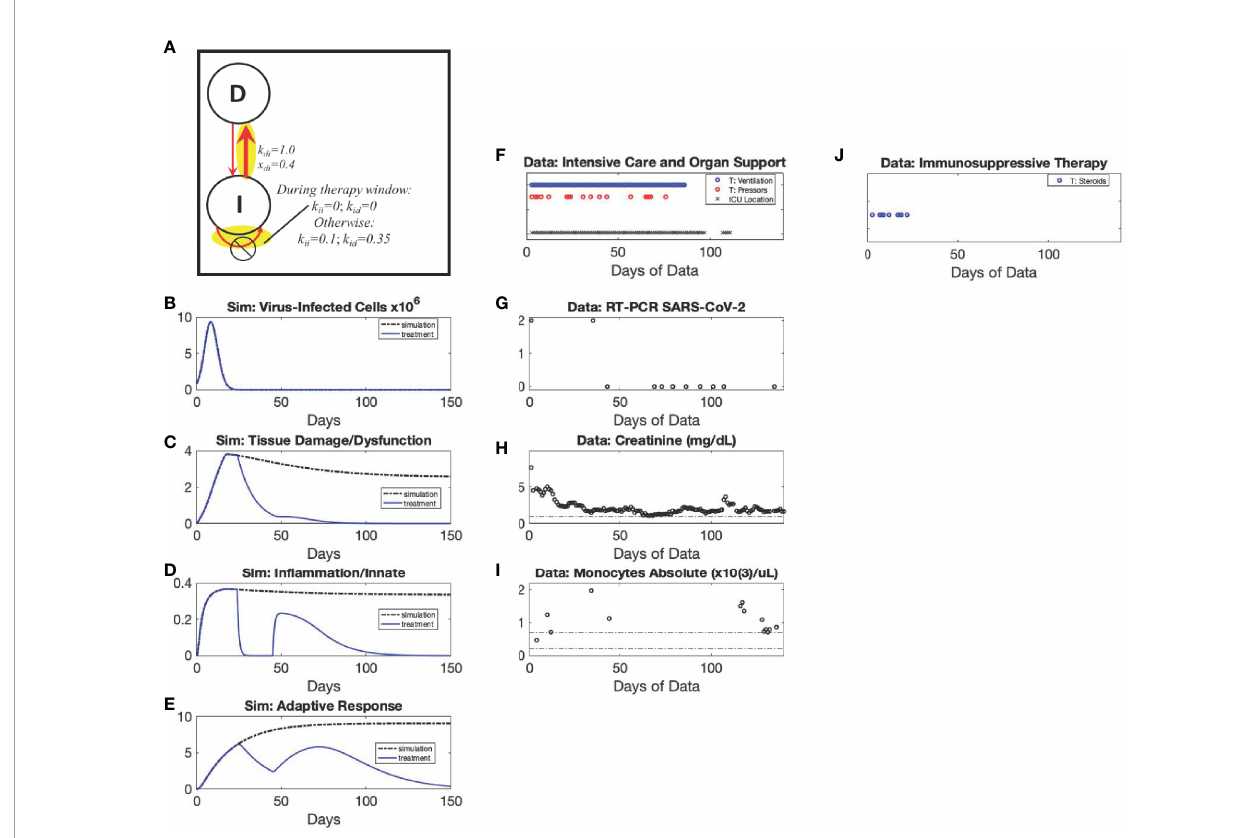
FIGURE 9 | Short-duration Anti-in fl ammatory Treatment: Damage-sustained In fl ammation archetype simulation with and without treatment vs . patient data. The Damage-sustained In fl ammation archetype emerges due to modifying the values of parameters k di and x di compared to the Recovery archetype, Mild scenario; and, when implementing the window of anti-in fl ammatory therapy, k ii and k id are set to zero as shown in the diagram (Panel A ). Simulated dynamics are shown of C V (Panel B ) (Initialized with a C V =8x10 5 virus-infected cells), D (Panel C ), I (Panel D ), and A (Panel E ) for the Damage-sustained In fl ammation archetype [black, dot- dashed curves, Panels (B – E) ]. An anti-in fl ammatory treatment simulation of this archetype is overlayed [blue, solid curves, Panels (B – E) ]. Panels (F – J) show data from a patient in their 50s with hypertension, chronic kidney disease, and obesity who, after two weeks of symptoms at home, presented hypotensive and in hypoxemic respiratory failure. The patient was intubated on hospital day 3 and given a methylprednisolone course on hospital days 7-11 as well as hydrocortisone stress steroids on hospital days 17-19. The patient was liberated from the ventilator by hospital day 86 and discharged to a skilled nursing facility by hospital day 140. Simulated Anti-in fl ammatory intervention was carried out in the Damage-sustained In fl ammation archetype of Figure 5 Panels B-E. By temporarily adjusting some of the model parameter values governing the generation of in fl ammation, I, the model simulation emulates the results of applying a broad-spectrum anti- in fl ammatory intervention resulting in massive suppression of in fl ammation. Treatment in the simulation started on day 24 (when virus-infected cells were still elevated, implying the possibility of a positive PCR result, C V =1.7x10 4 cells), where we estimated this by adjusting for the 14 days of symptoms prior to admission plus steroids started at day 7. The patient only received 13 days of treatment; however, our estimated window of 21 days used in the simulation resulted in a favorable outcome as opposed to shorter times investigated ( Figure S4 ). The simulated therapy shows that while in fl ammation is drastically reduced during the treatment window, there is a resurgence after the treatment is stopped (See Panel D, blue curve, and Panel I, Data: Monocytes Absolute) due to the continued presence of in fl ammation-inducing Damage/Dysfunction (See Panel C, blue curve, and Panel F, Data: Intensive Care and Organ Support). However, the treatment is enough to reset the response dynamics in the simulation so that resolution is achieved by 150 days, having signi fi cantly inhibited the subsequent creation of D and stopping the positive I to D feedback